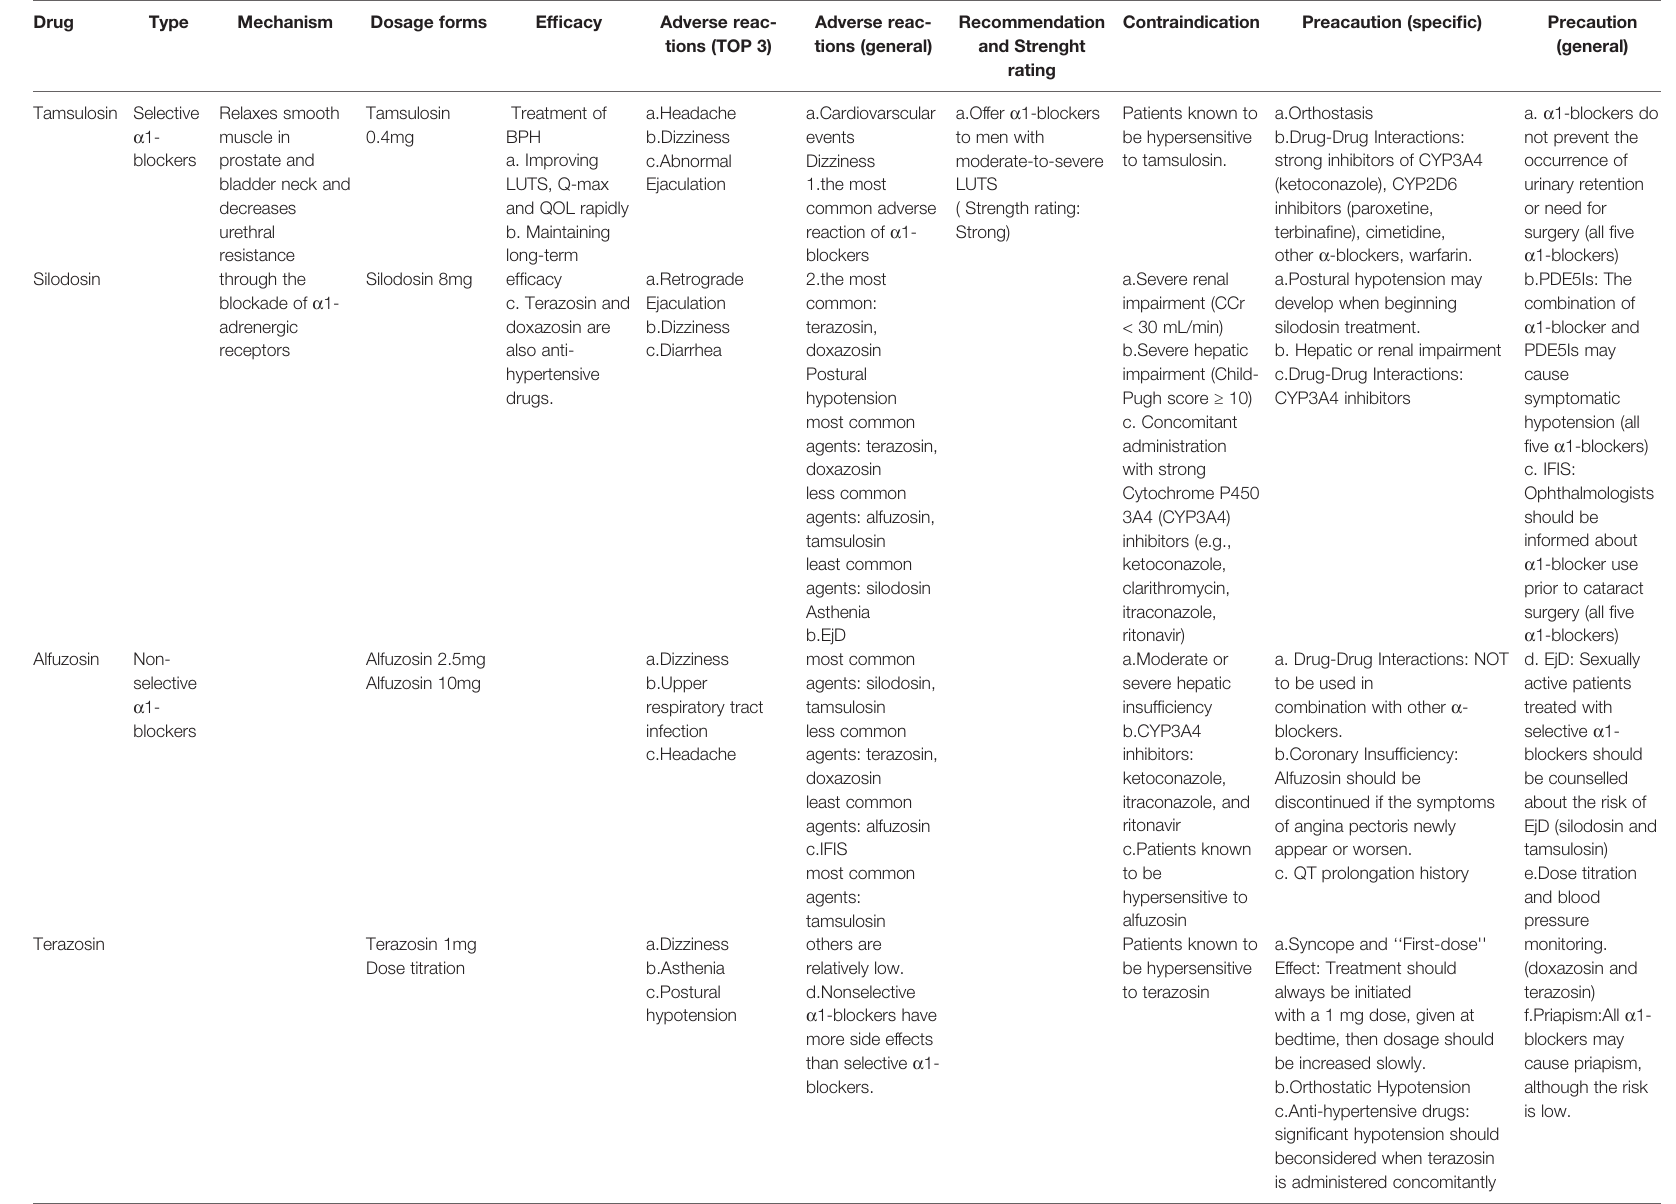
TABLE 1 | The ef fi cacy and safety of several common drugs approved by the FDA for the treatment of LUTS/BPH.